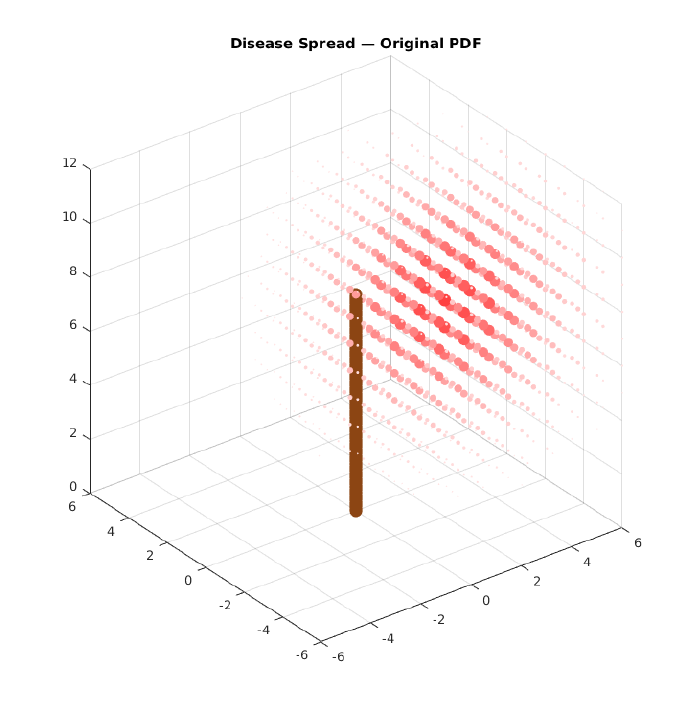
Figure 16. Arbitrary PDF display. The larger and more colorful red dots have a bigger probability density. The brown cylinder represents the main tree